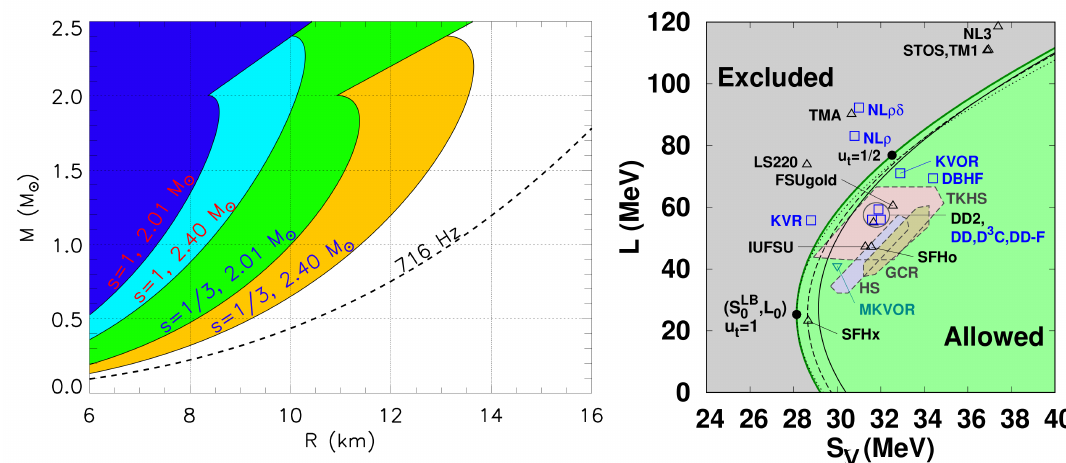
Figure 1. Left : Regions excluded by the maximum compactness conjecture . The dark (light) blue region is excluded when M max = 2.01 M (cid:12) ( 2.4 M (cid:12) ) . Alternatively, regions excluded by the s = 1/3 EOS are shown as the green and orange regions. The dashed line denotes the maximum radius from the Keplerian constraint applied to the most-rapidly-spinning pulsar, PSR J1748-2446ad, adapted from Ref. [14]. Right : The gray region is excluded by the unitary gas conjecture. Symbols indicate parameters from various published EOSs and the colored polygons show neutron matter predictions, adapted from Ref.